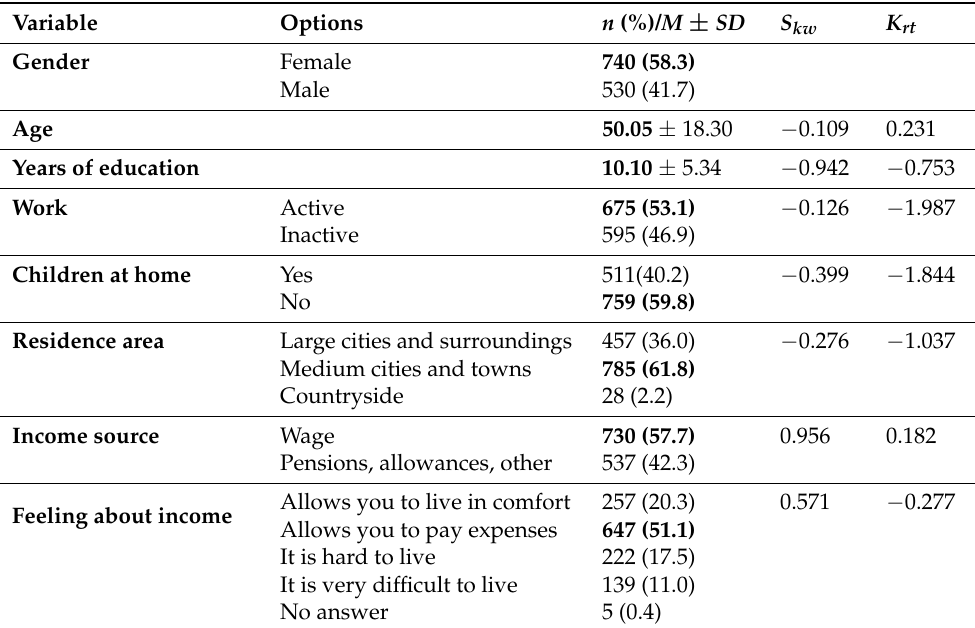
Table 1. Sociodemographic characteristics of the sample (N =